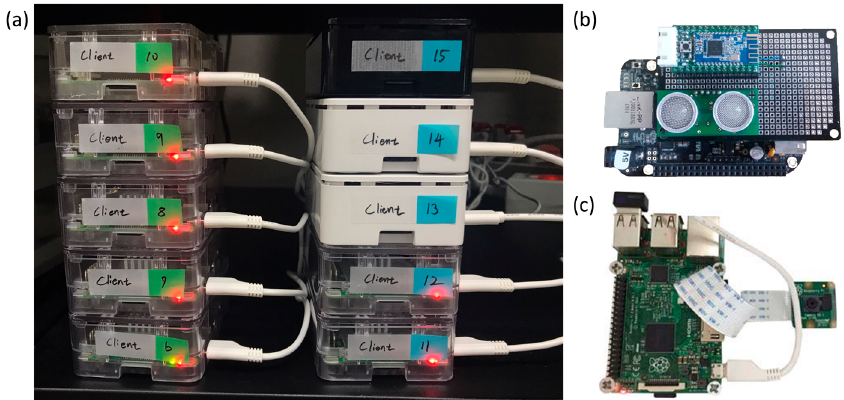
Figure 13. Experiment environment implemented using MinT. ( a ) client modules for experiment, ( b ) server module with ultrasonic sensor, ( c ) server module with camera sensor